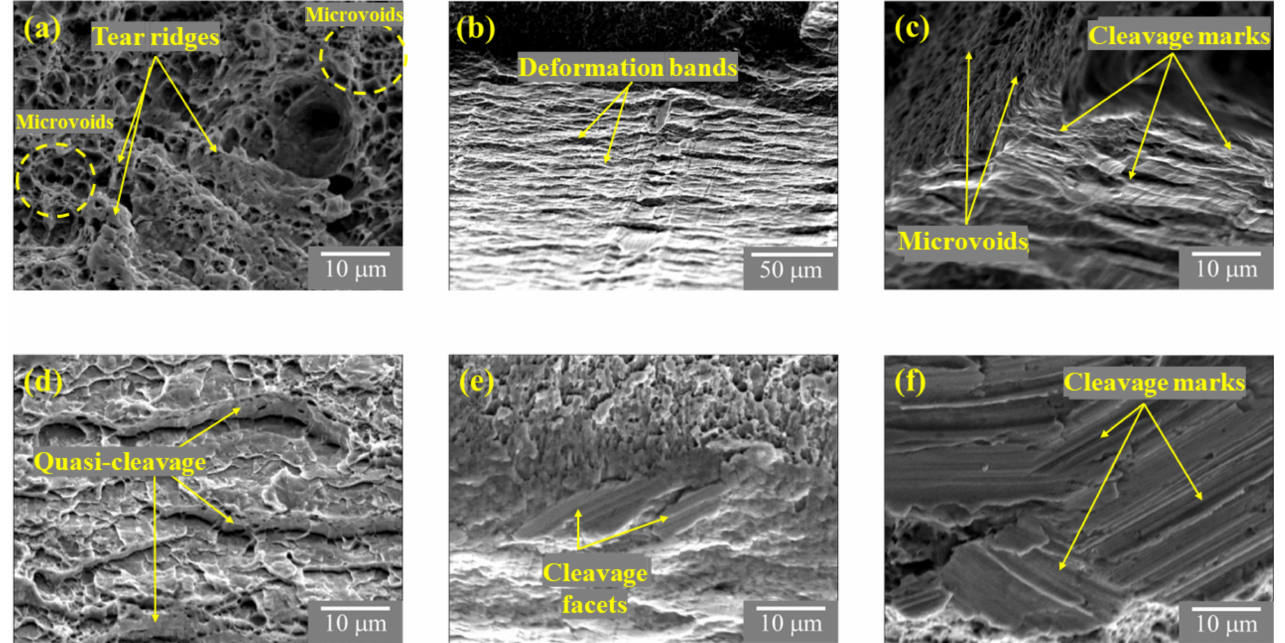
Figure 17. Details of different fracture features along the failed sample. ( a ) shows microvoids, ( b ) exhibits deformation bands at the outer face of a shear lip, ( c ) mixture of ductile and brittle zones at the inner wall of a shear lip, ( d ) quasi-cleavage, ( e , f ) evidence